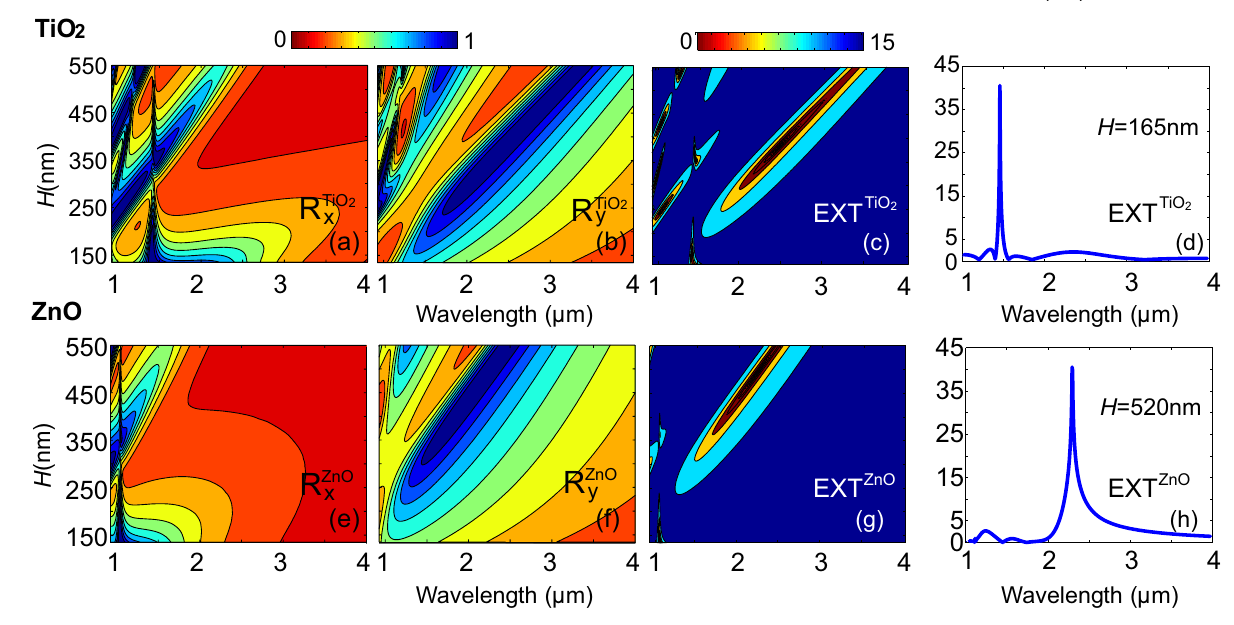
Figure 4. ( a , b , e , f ) Normalized reflected power, R , for two plasmonic gap metasurfaces of variable TiO 2 [top panels ( a ) and ( b )] and ZnO [bottom panels ( e ) and ( f )] insulating cavity thickness in the range H = 135 − 550 nm for both polarizations, i.e, the electric field being normal to the top layer nanowires, E = E x [panels ( a ) and ( e )] and the electric field being parallel to the top layer nanowires E = E y , [panels ( b ) and ( f )]; TiO 2 ZnO TiO 2 ZnO R y in ( f ). ( c ) and ( g ) Extinction ratio of the reflected power between y in ( b ), R x in ( e ), R x in ( a ), R the two polarization, EXT = 10log 10 ( R x / R y ) saturated in [0–15] dB for the TiO 2 and ZnO cases with variable ZnO TiO 2 cavity thickness in the range H = 135 − 550 nm, EXT in ( c ) and EXT in ( g ). ( d ) and ( h ) Wavelength dependence of the extinction ratio in the range (cid:31) = [1–4] μm for the thinner TiO 2 ( d ) and the thicker ZnO ( h ) case calculated at an optimum cavity thickness H